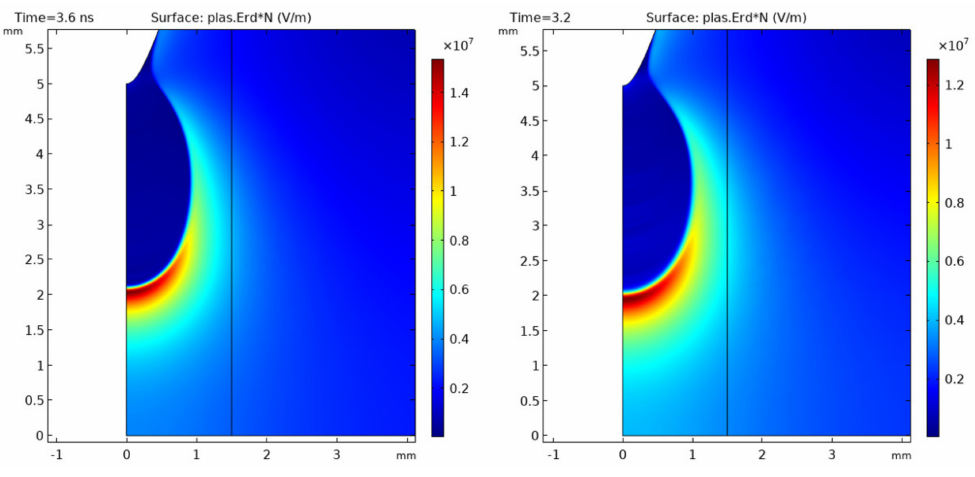
Figure A1. 2D surface plot of electric field for S b = 10 15 m − 3 s − 1 ( left ) and S b = 10 23 m − 3 s − 1 ( right